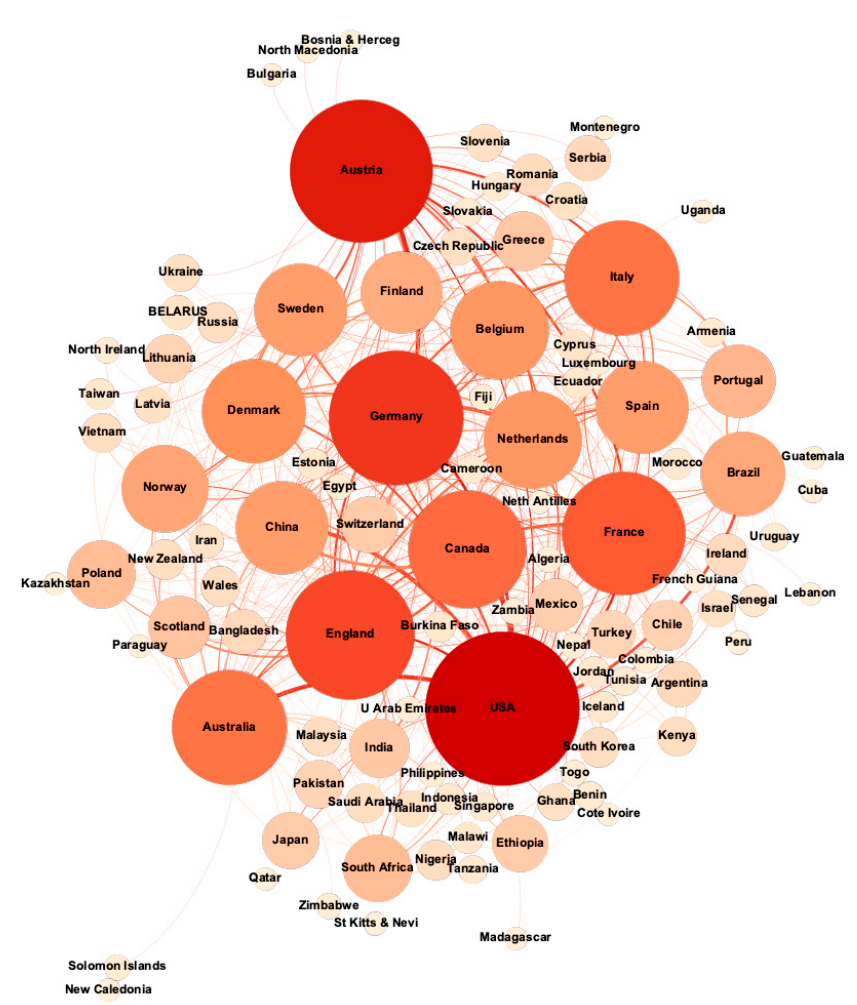
Publications 2020 , 8 , x Figure 5. Representation of international articles per country ( n = 790 articles, Gephi software). Figure 5. Representation of international articles per country (